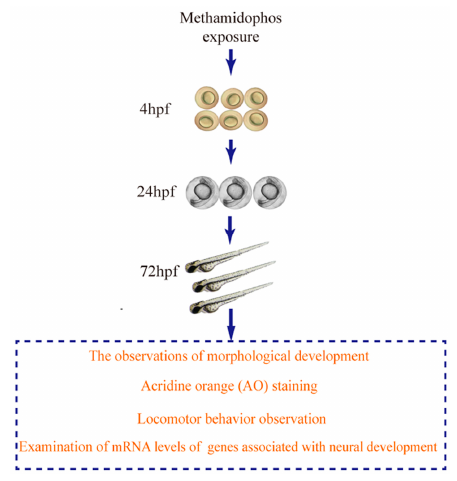
Figure 1. Experimental work flow of this study.